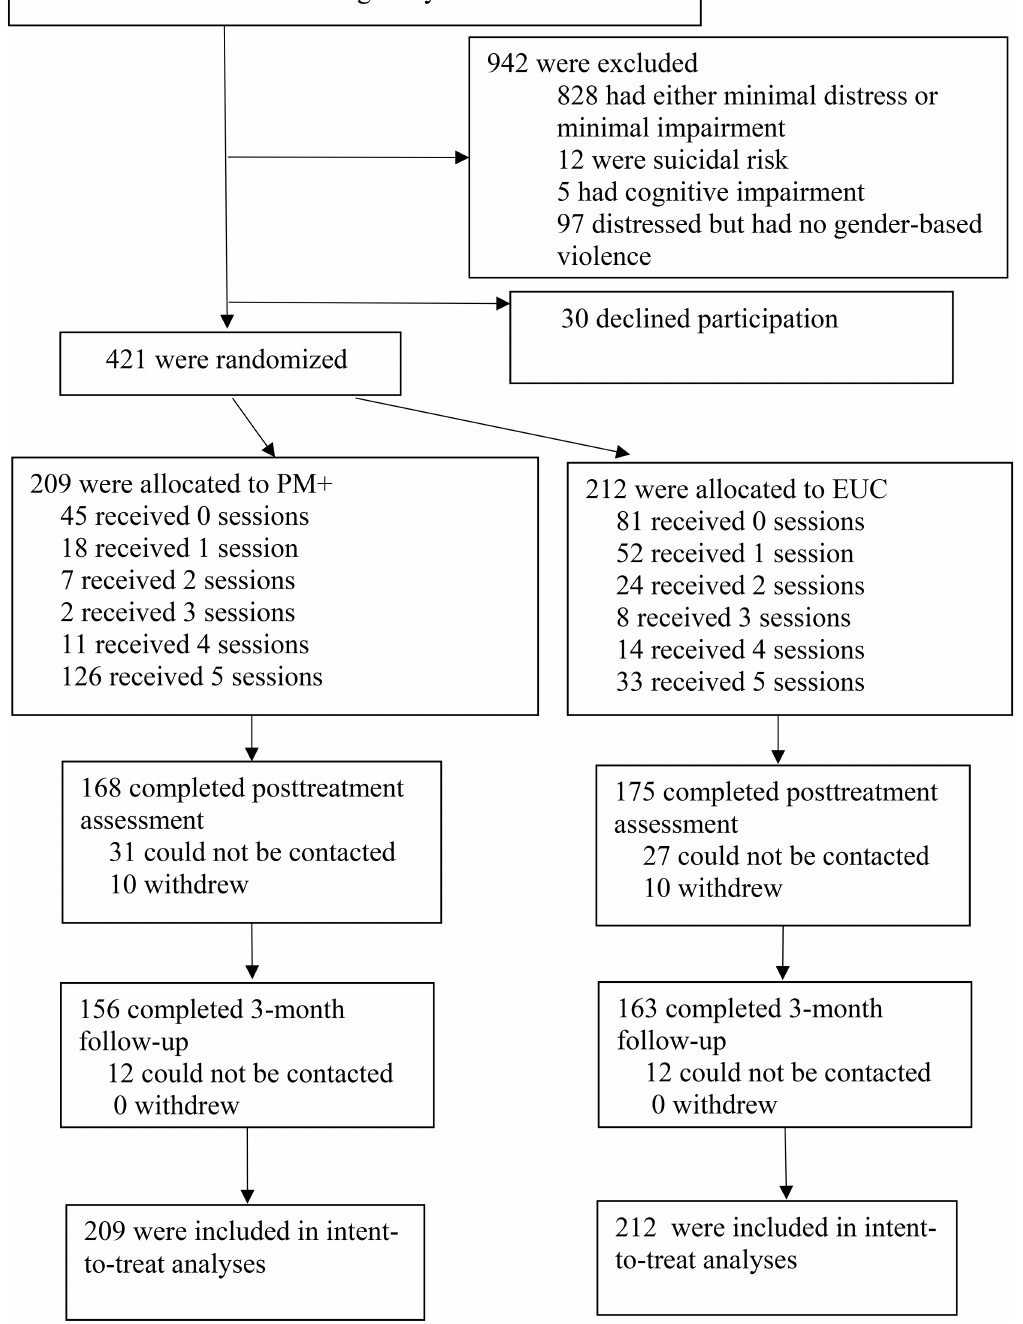
Fig 1. Flow diagram of progress through phases of a randomised trial comparing problem management plus versus enhanced usual care among women with a history of gender-based violence in urban Kenya. EUC, enhanced usual care; PM+, Problem Management